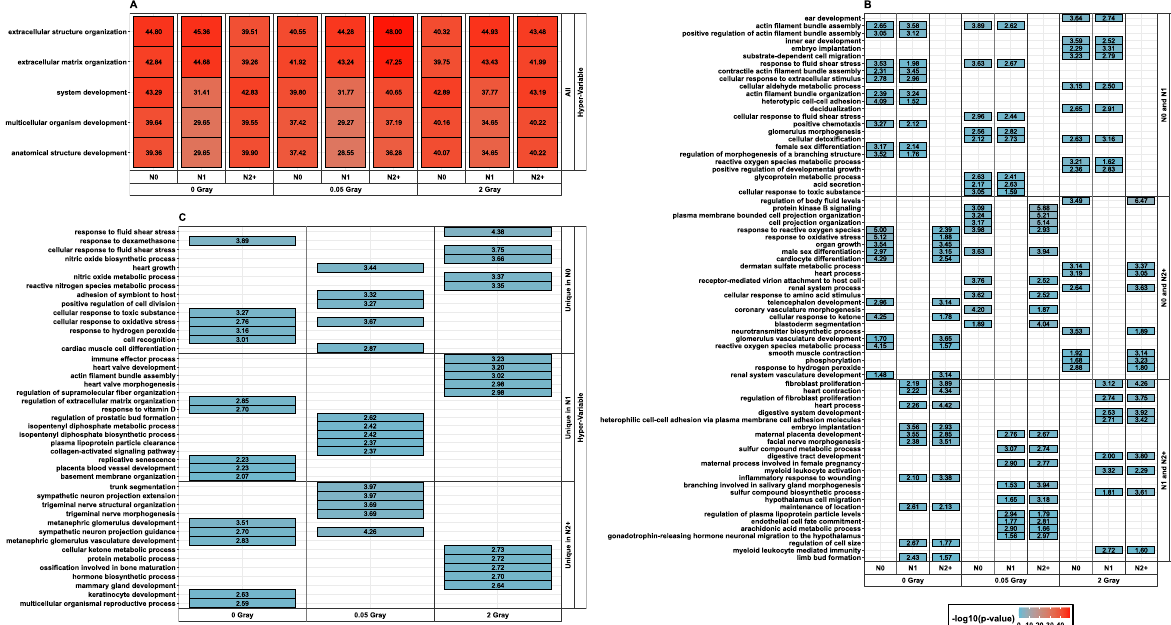
Fig. 4 Summary of the top 5 Gene Ontology terms regarding the adjusted p ‑value: stratified by group‑wise overlap (Top 5 in A all groups, B overlap of two donor groups, and C unique in one group), per radiation dose for genes classified as hyper‑variable. Inside the tiles, each respective adjusted log 10 ( p ‑value) is provided. Since a p ‑value was computed per group for A ) and B ), the top 5 GO terms e.g., found only in N0 and N1, but not in − N2 post‑HDIR might differ. In this case, the top 5 for N0 and N1 are shown each, resulting in more than 5 terms. N0 + controls, N1